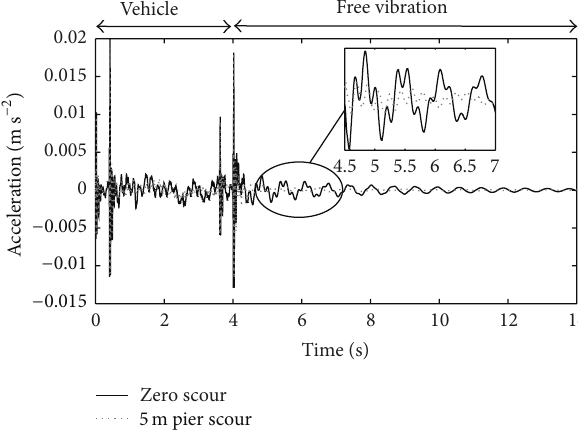
Figure 10: Difference in lateral pier top acceleration for 0 and 5 m